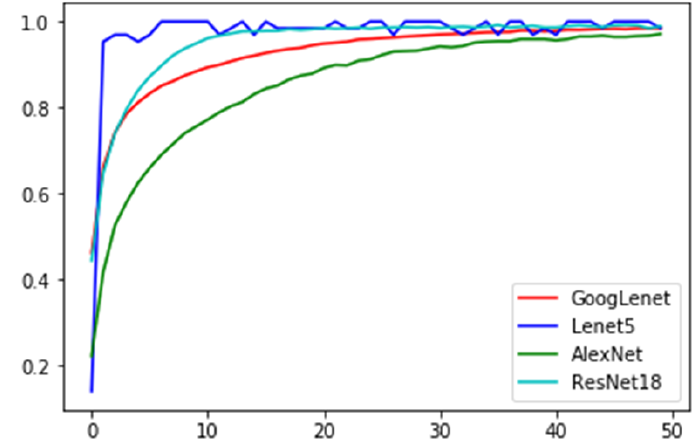
Figure 5. Network training accuracy.